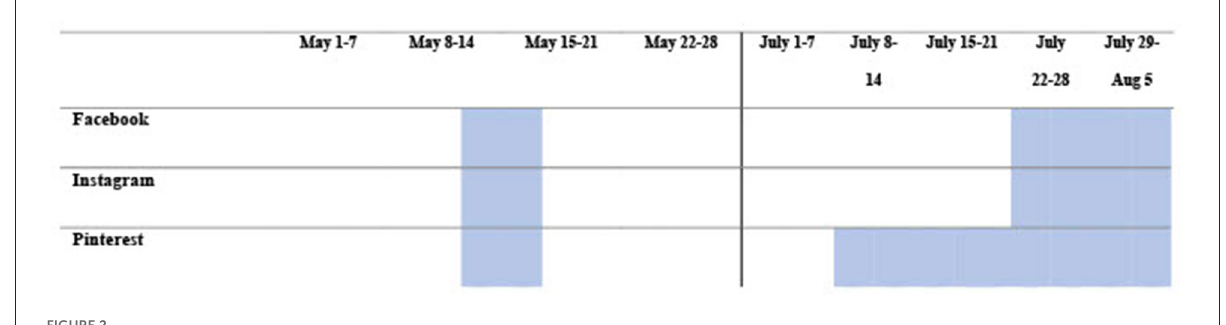
FIGURE2 Campaign schedule for Facebook, Instagram, and